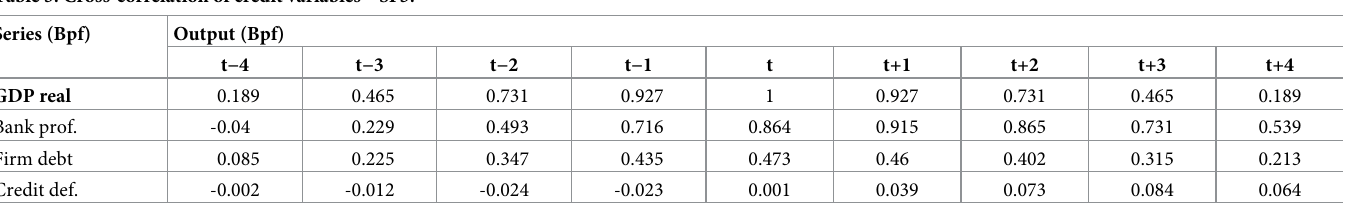
Table 3. Cross-correlation of credit